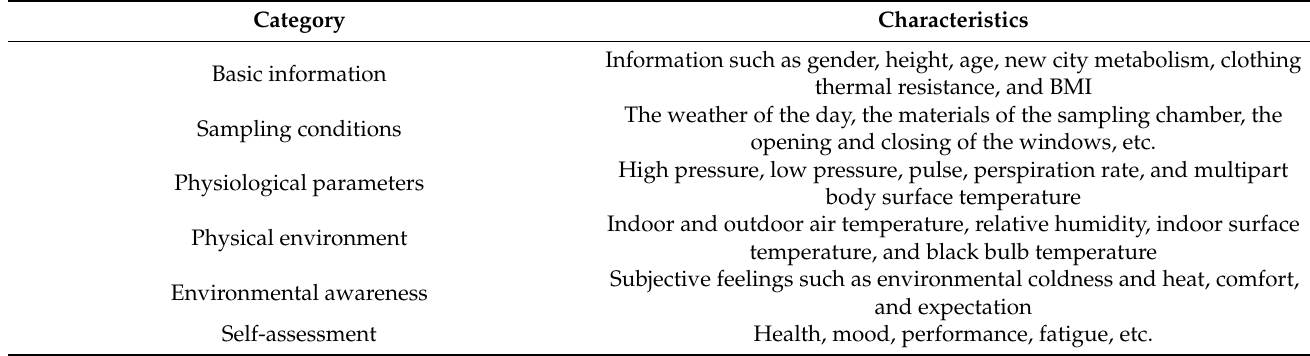
Table 1. Selected features for the development of TMV-TSK-FC personal thermal comfort models.